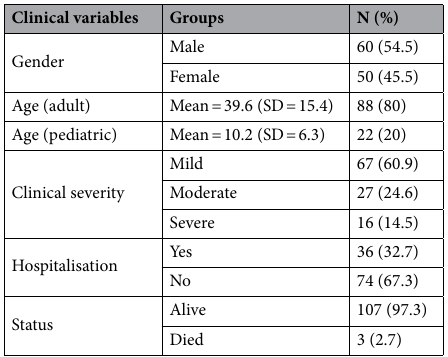
Table 1. Demographic data of patients from which SARS-CoV-2 samples were